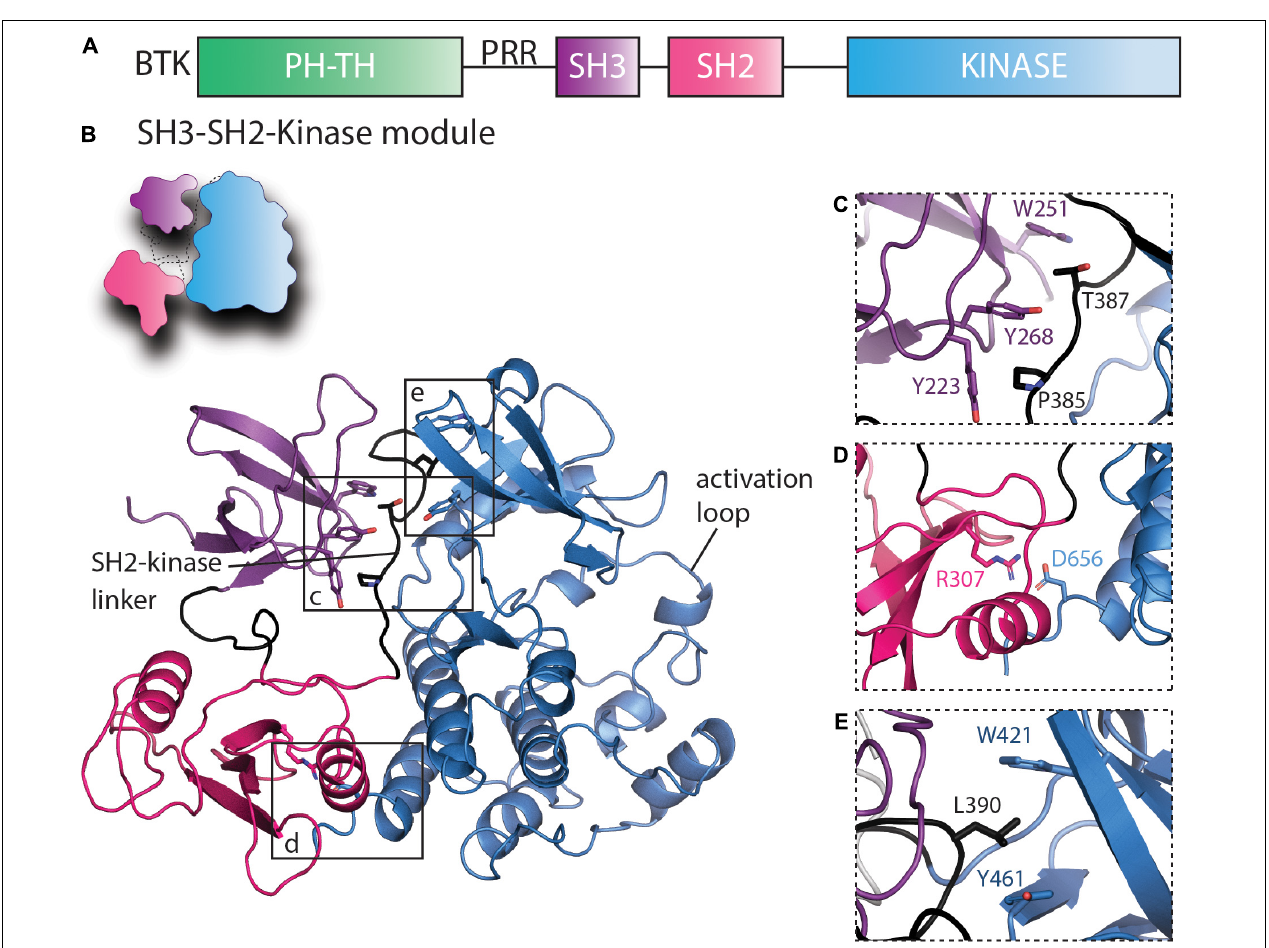
FIGURE 3 | Regulatory interactions within the SH3–SH2-kinase module of BTK that maintain the inactive conformation. (A) Domain schematic of full-length BTK with the PHTH, SH3, SH2, and kinase domains colored green, purple, pink, and blue, respectively. The proline-rich region (PRR) between the PHTH and SH3 domains is labeled. (B) A cartoon of the autoinhibited BTK SH3–SH2-kinase model and the BTK SH3–SH2-kinase structure (Wang et al., 2015) are shown using the same domain colors as in panel (A) . The SH2-kinase linker and the activation loop are labeled, and boxes show the regions expanded in panels (C–E) . (C) The intramolecular interaction between SH3 domain residues Y223, W251, and Y268 and the SH2-kinase linker residues P385 and T387 stabilize the SH3 domain onto the distal side of the kinase domain (opposite the activation loop face). (D) The salt bridge contact between SH2 R307 and D656 in the kinase domain stabilizes the SH2 domain on the distal side of the kinase domain C-lobe and mimics the SH2/C-terminal tail phosphotyrosine interaction of the SRC kinases (Liu et al., 1993). (E) L390 in the SH2-kinase linker and W421 and Y461 in the kinase domain N-lobe form the hydrophobic stack.